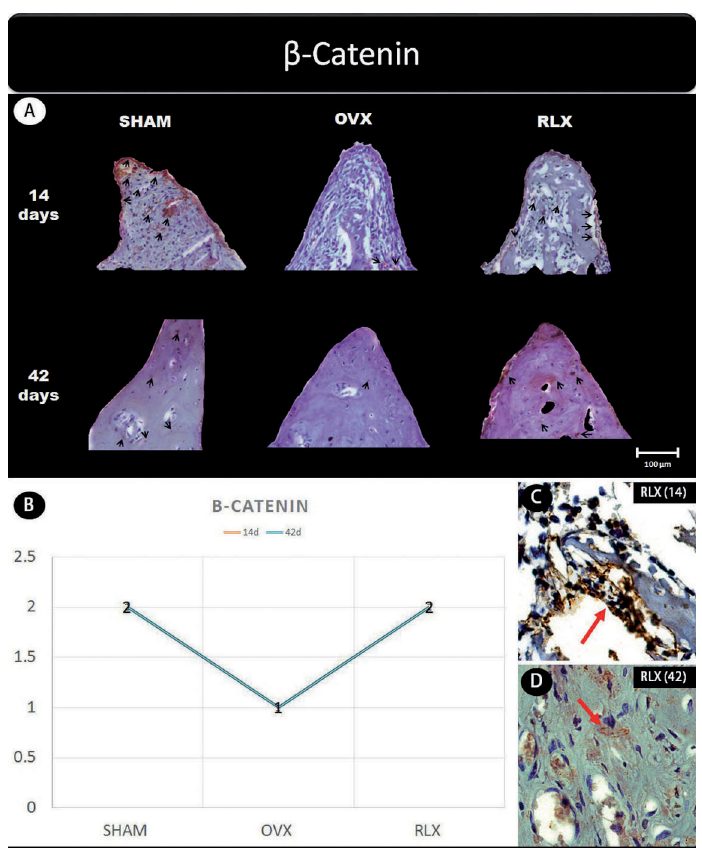
Figure 2- (A) Photomicrographs in a higher original objective (x40) of the different groups (SHAM, OVX, and RLX) and periods (14 and 42 days), in which is possible to observe an increased area of diaminobenzidine-stained cells (brown areas) around the peri-implant bone where the biomarker β-catenin were intense, represented by black arrows, denoting an improvement in the bone formation; (B) The chart shows the scores submitted to the Kappa test, in which the index was adjusted to >0.8, representing the expression of β-catenin among the groups and in both periods; (C and D) Photomicrographs in a higher original objective (x100) about the 14 and 42 days of peri-implant bone healing from RLX group showing a moderate labeling of the biomarker β-catenin represented by red